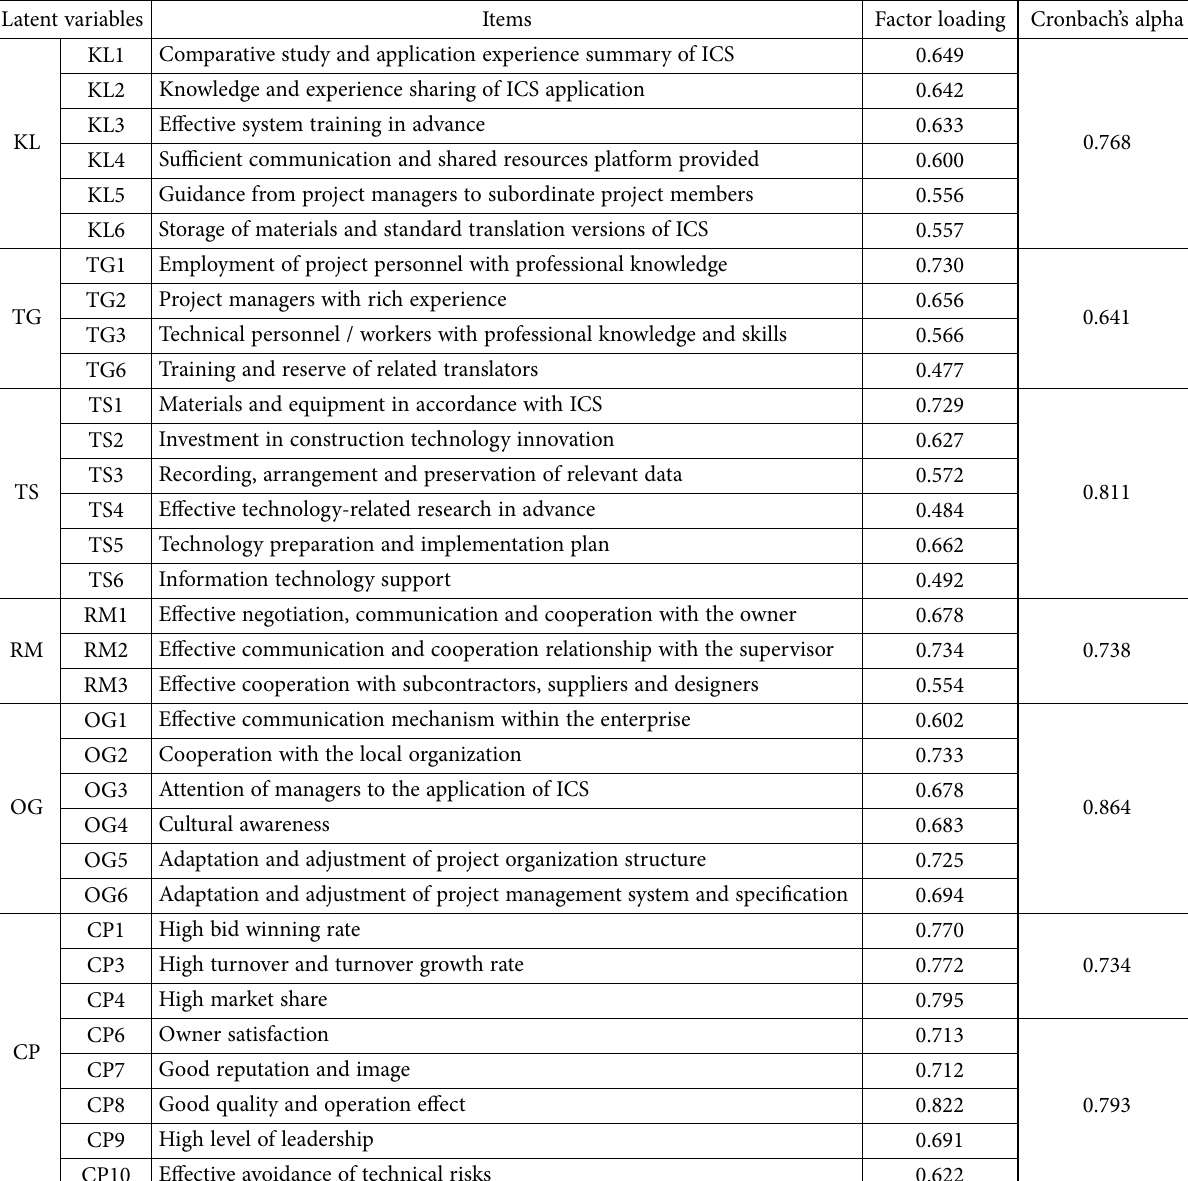
Table 4. Factor loading and Cronbach’s alpha of latent variables